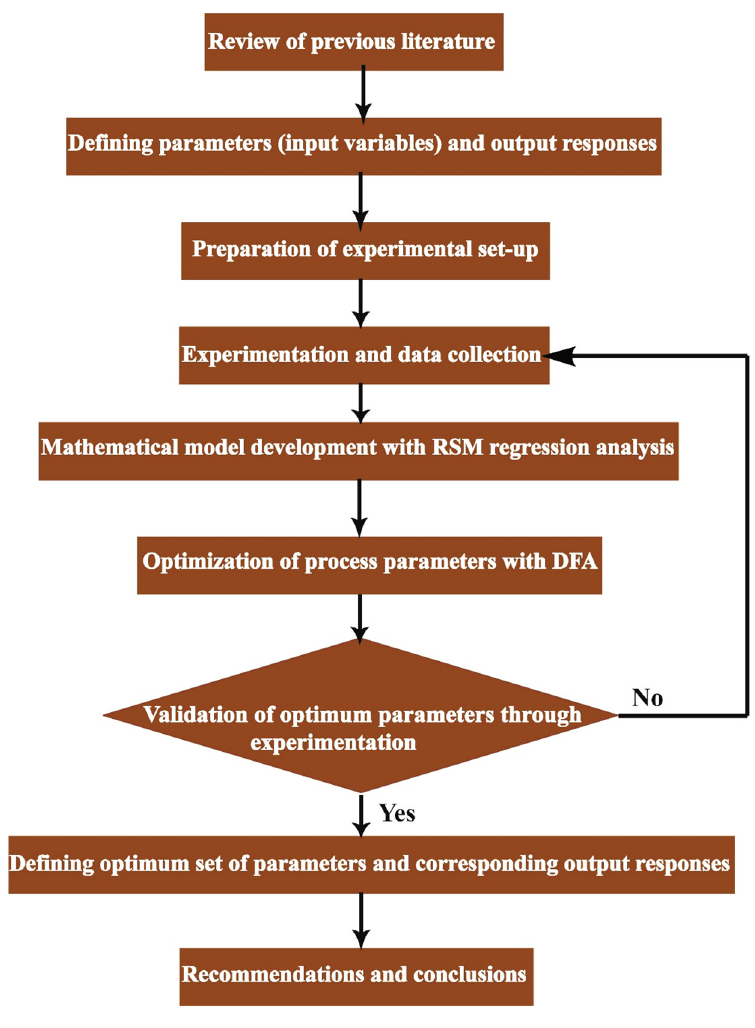
Figure 1. Flow chart of current research. Table 2. Chemical composition and properties of the workpiece